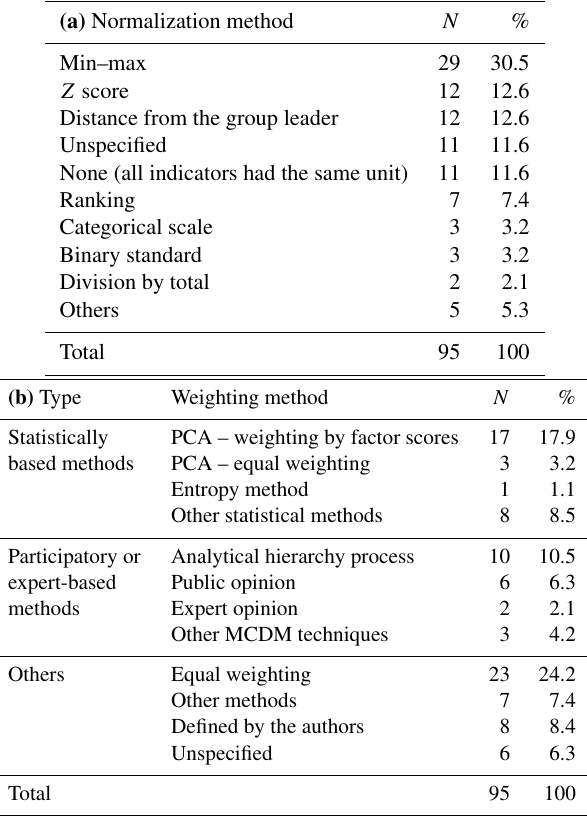
Table 6. Normalization and weighting